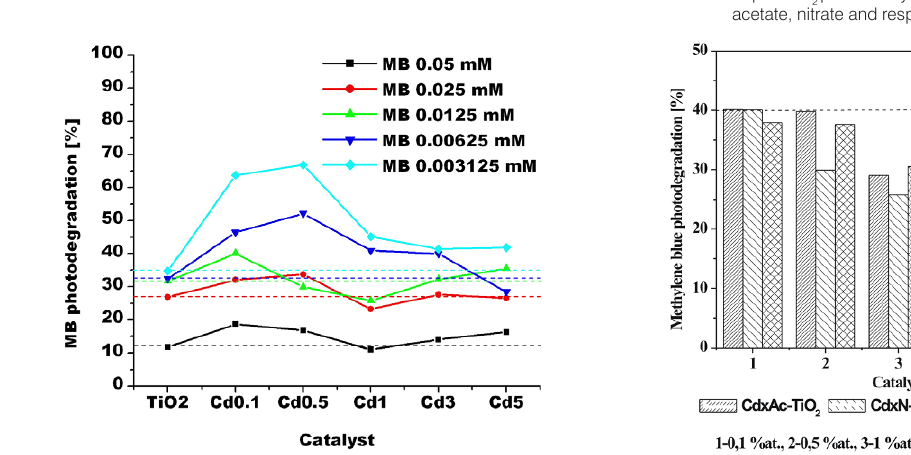
Figure 4. Photocatalytic degradation of Methylene blue after 6 h of irradiation.